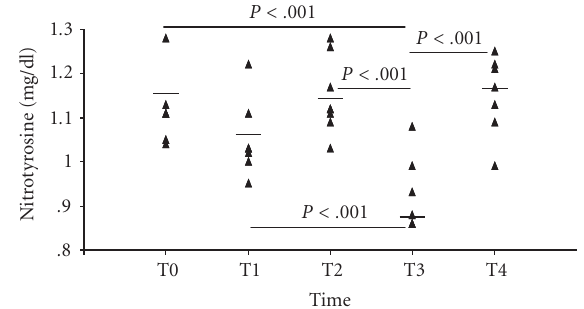
Figure 2: Individual data points of nitrotyrosine levels in EBC at the times of the study (T0, T1, T2, T3, and T4). Marked short lines represent mean